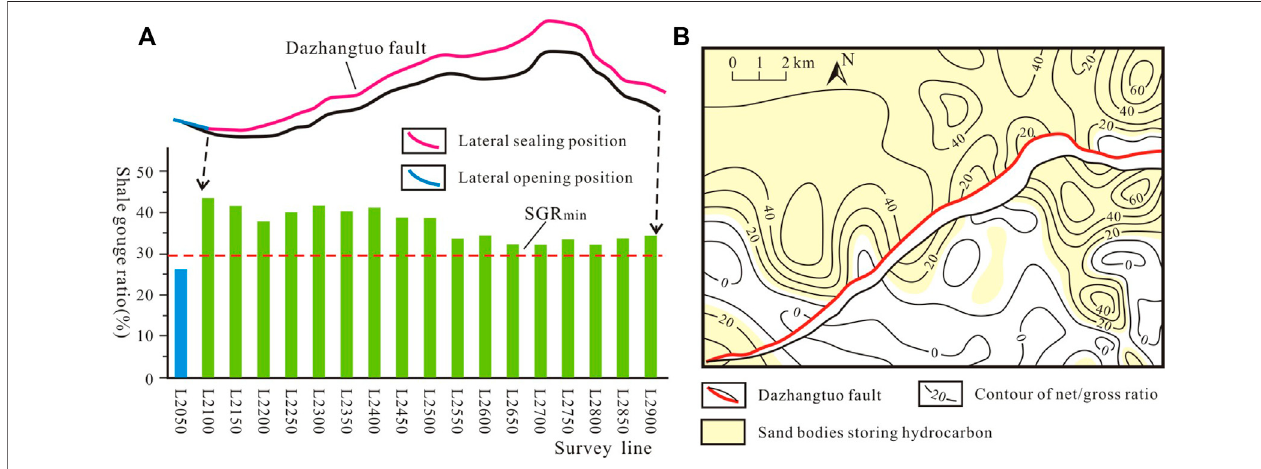
FIGURE 8 | Determination of hydrocarbon accumulation positions along the Dazhangtuo fault. (A) Lateral sealing position of the Dazhangtuo fault in the Ban 2 oil group. (B) the area of sand bodies storing hydrocarbons in the Ban 2 oil group.